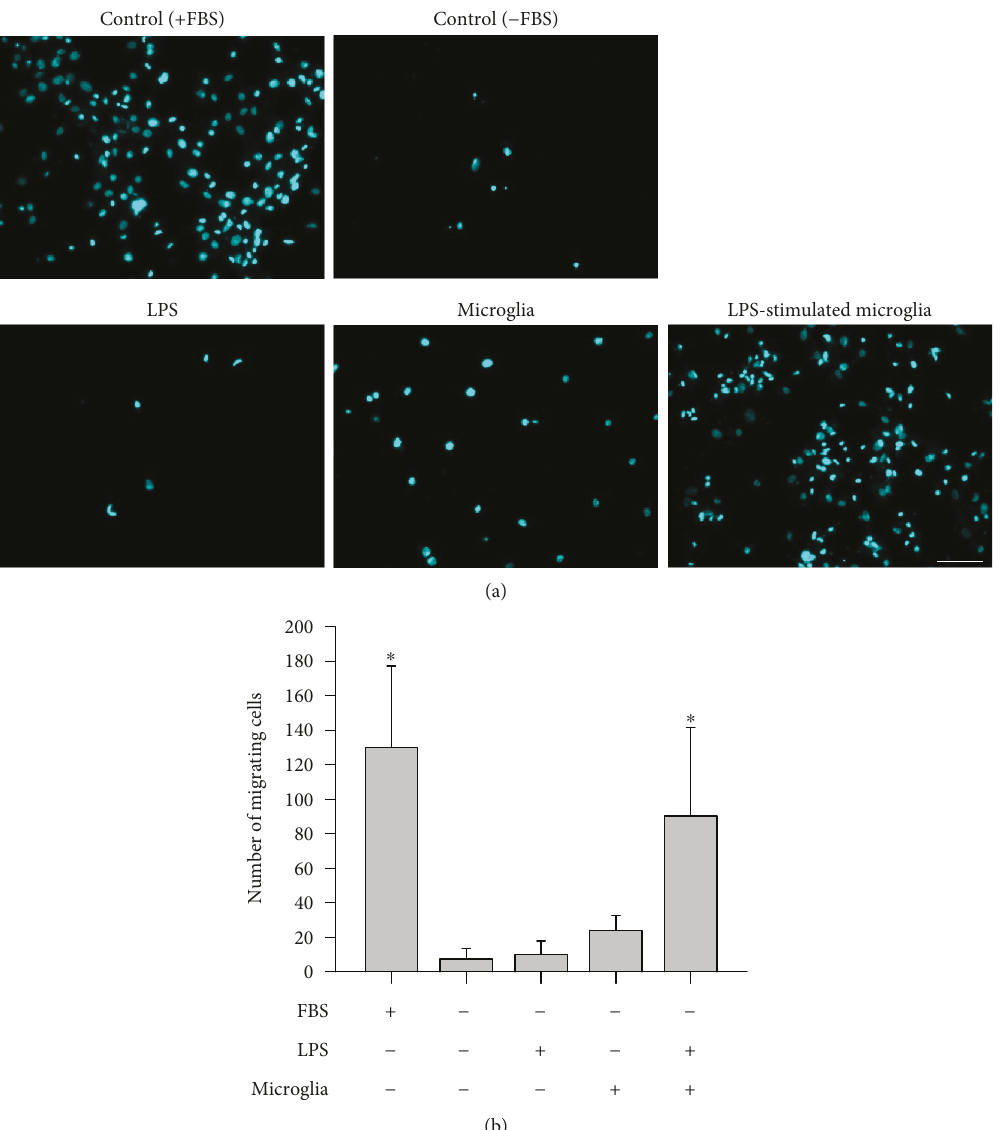
Figure 3: Migration assays with rat bone marrow-derived mesenchymal stem cells (rBM-MSCs) cocultured with LPS-stimulated microglia. (a) Images of migrating rBM-MSCs. Migration of rBM-MSCs was investigated in 5 di ff erent conditions: media containing foetal bovine serum (FBS) (positive control), media without FBS (negative control), LPS-treated, cocultured with microglia, and coculture with LPS-stimulated microglia. Migrating cells are cyan in colour (10x magni fi cation). Representative images of migration for each condition are shown. Scale bar: 100 μ m. (b) Quanti fi cation of migrating cells was performed by counting coloured dots in the images. Data represent the mean of ten random 372.23mm 2 (710.52 μ m × 532.38 μ m) microscopic fi elds ( mean ± SD ). ∗ p < 0 05 versus negative control (media without